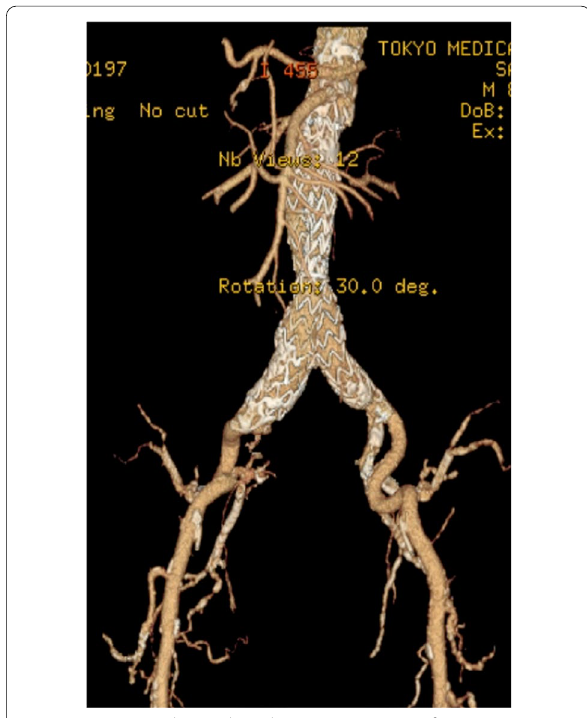
Fig. 2 Contrast-enhanced CT showing an oozing of contrast medium on the main body and left